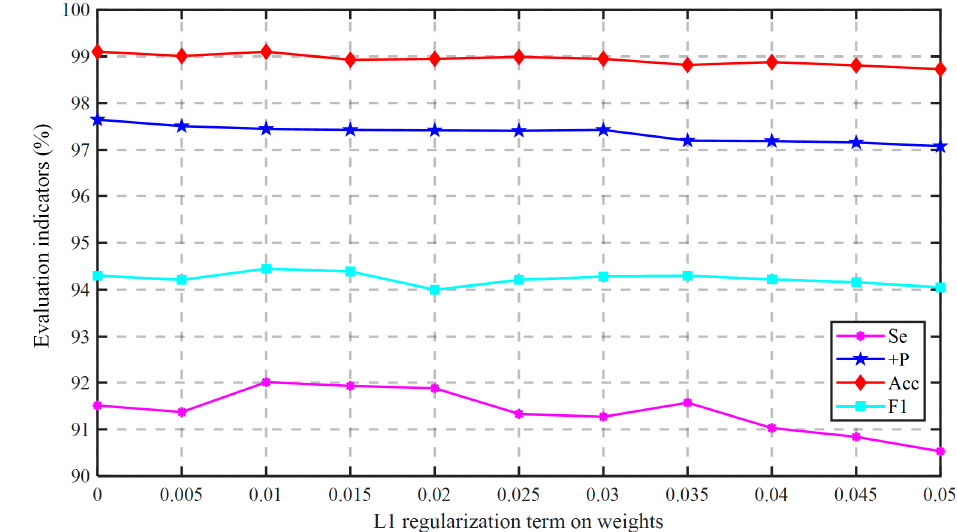
Figure A6. The performance change with the “reg_alpha”.